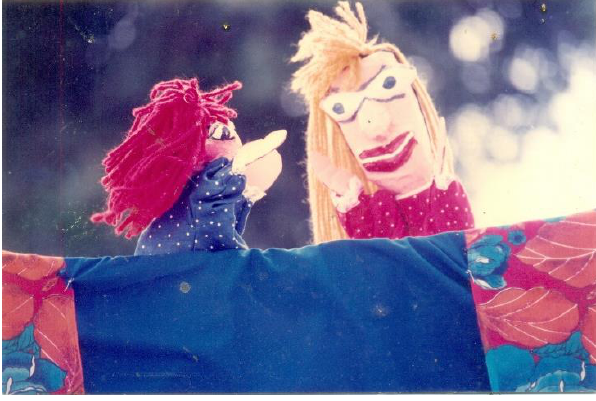
Figure 3. Paper-mache puppets show by Maria Oliveira in 1980’s. As Castro (2015) states the puppets are traditionally made of wood, of which are sculpted their heads and hands, and also of cloth to make the dressing. The dramatic structure of the show calls for the puppet to be tough and durable.